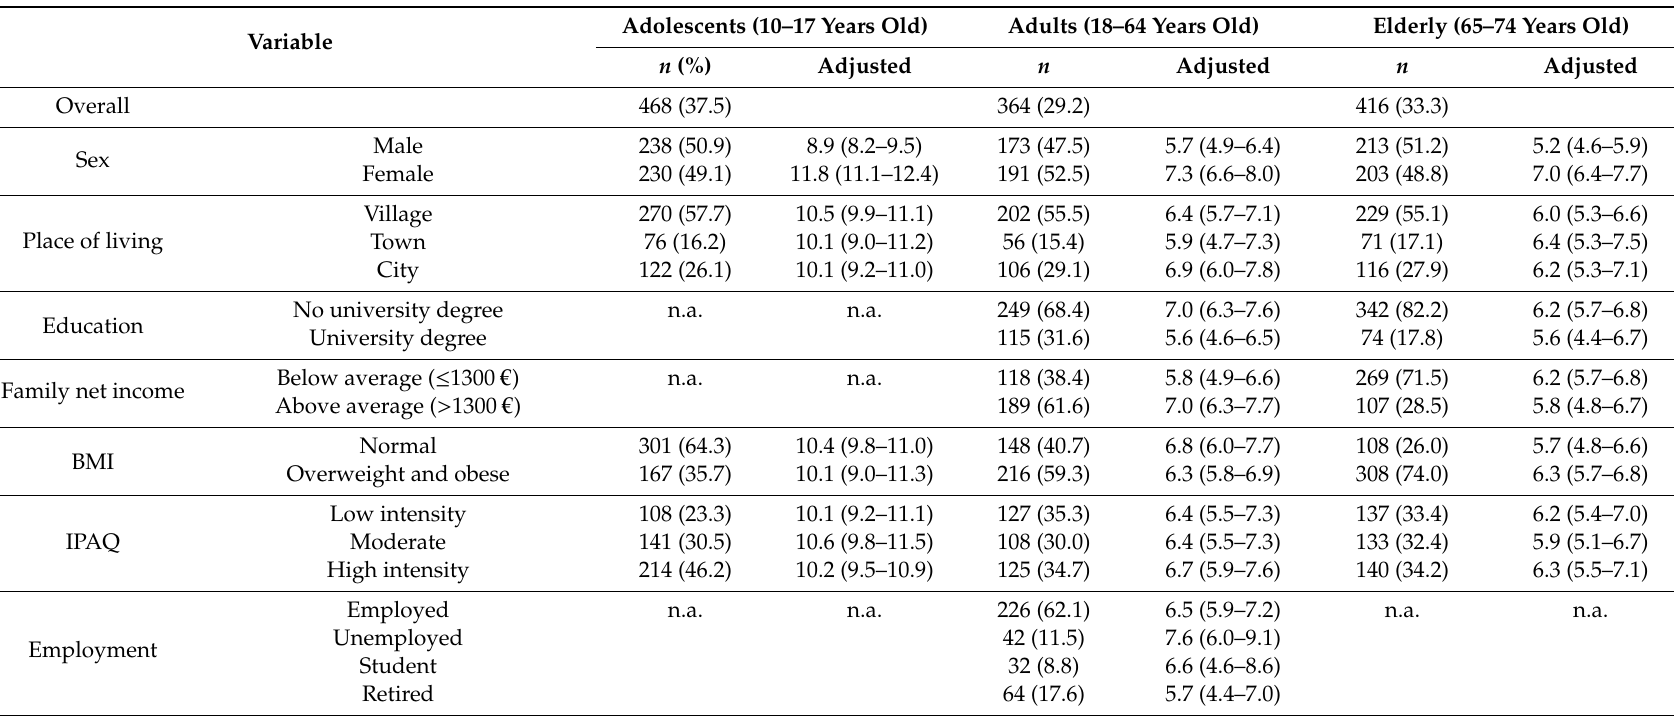
Table 3. Adjusted mean (95% CI) levels of free sugars (% TEI) intake by sex, place of living, BMI, IPAQ score, education, income, and employment for di ff erent age